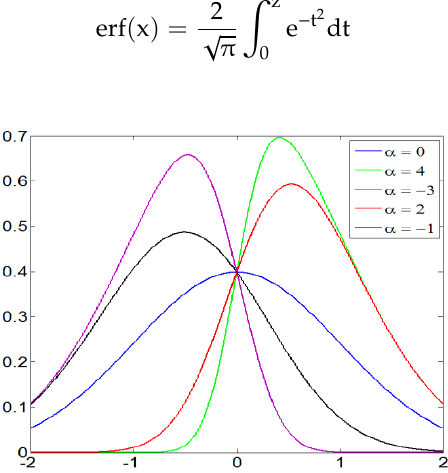
Figure 7. Skew normal distribution with parameter α.